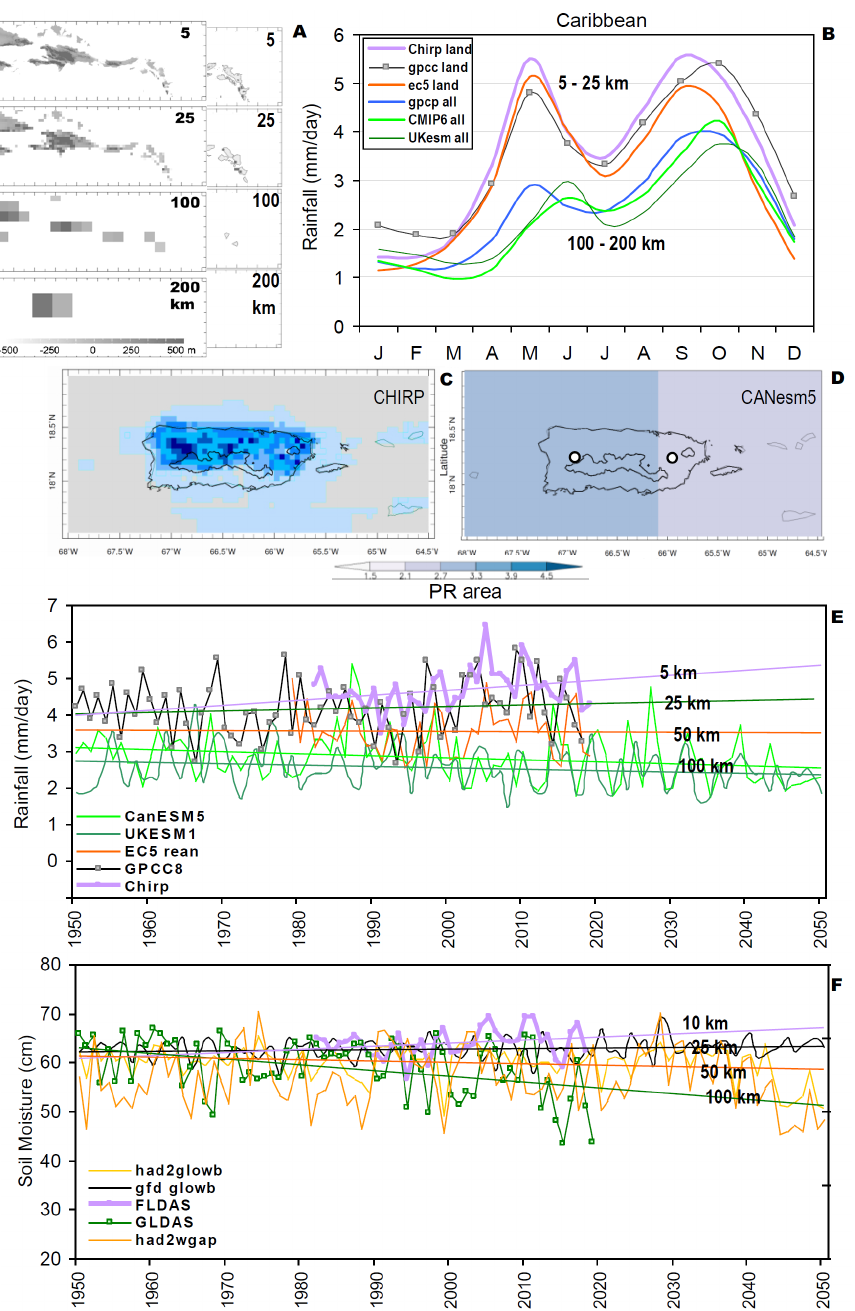
Figure 10. ( a ) Shelf and island topography at resolution from 5–200 km (shaded light to dark grey − 500 to 500 m elv). ( b ) Mean annual cycle (1980–2019) of land-only and all Caribbean rainfall per dataset. Comparison of mean pattern of annual rainfall: ( c ) CHIRP and ( d ) cGCM (mm / day). Time series and trends over Puerto Rico in observed and model datasets with resolution labeled: ( e ) rainfall, and ( f ) soil moisture. Trends for observed values are extrapolated into the future assuming persistence. River discharge (cf. Figure 8c) at dots in d) above.